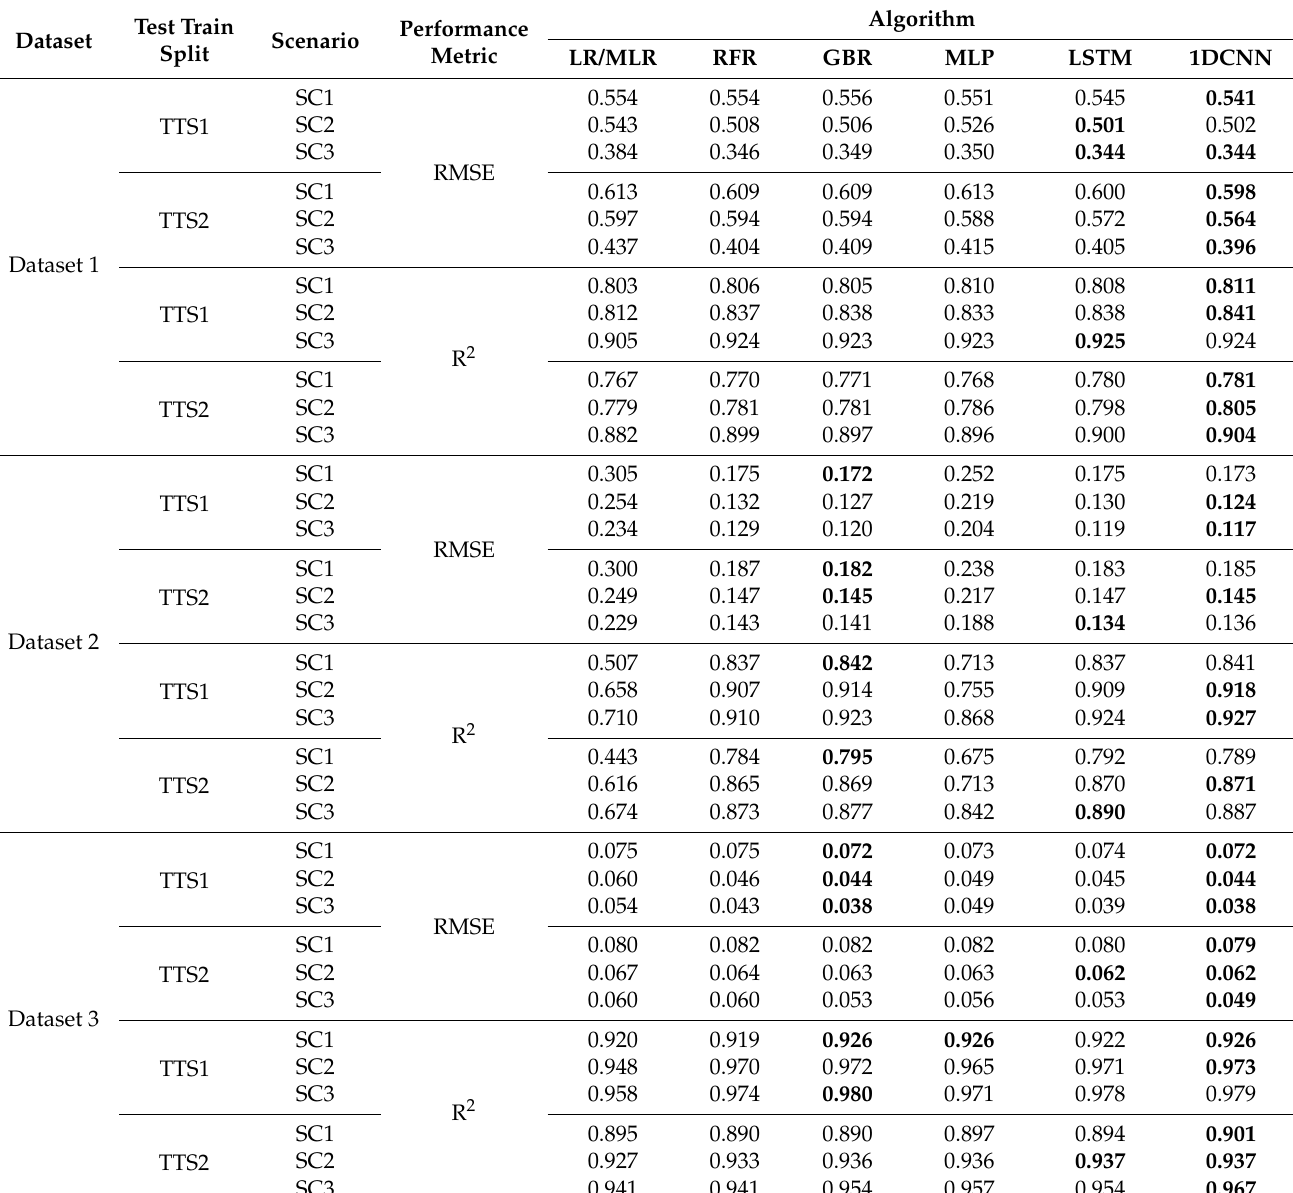
Table 4. The accuracy of the calibration algorithms in terms of R 2 and RMSE (in ppm). The best performance for each scenario is